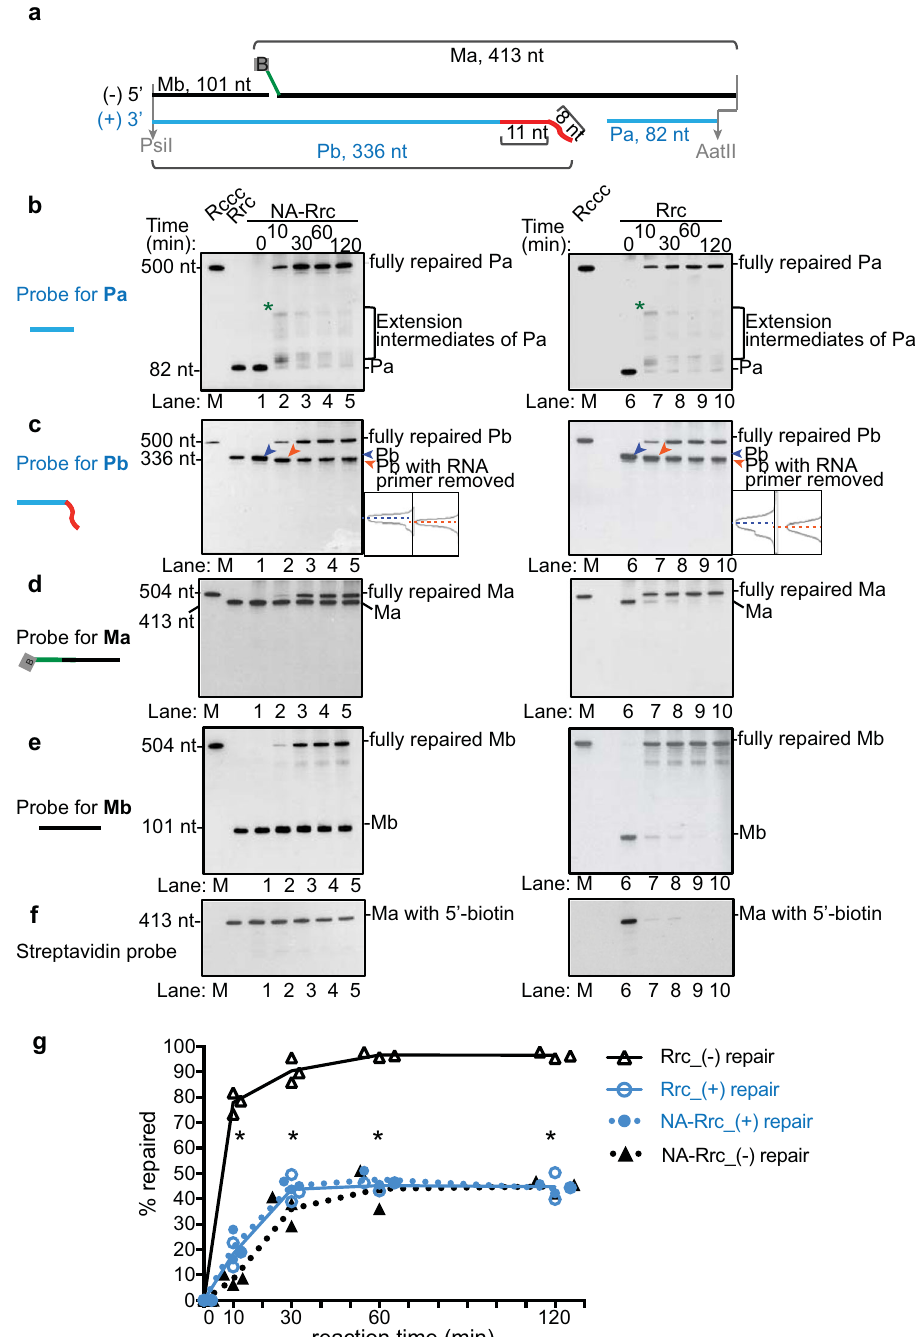
Fig. 3 Repair of HBV lesions in human nuclear extracts. a A simpli fi ed schematic depicting the four fragments in unrepaired RrcDNA digested by AatII/ PsiI. b NA-RrcDNA (lanes 1 – 5) or RrcDNA (lanes 6 – 11) was incubated with human nuclear extracts in a time course assay. Repair products at various time points were digested with Aat II/ Psi I and subsequently resolved by UREA-PAGE gel. Repair of the plus-strand Pa fragment was monitored by Southern blot as in Fig. 2d. “ * ” indicates extended Pa fragments that reach the 5 ′ terminus of Pa. c Repair of the plus-strand RNA primer-containing Pb fragment was monitored by Southern blot as described in Fig. 2e. Traces with dashed blue and orange lines denote unprocessed (blue arrow head) and processed product (orange arrow head) of Pb fragments. d – e Repair of the minus-strand Ma and Mb fragments were monitored by Southern blot as in Fig. 2f, g. f Removal of the biotin-containing fl ap of Ma was detected by streptavidin blot as in Fig. 2h. g The repair ef fi ciency of plus- and minus-strands is calculated from c and d and plotted as in Fig. 2i. ( − ) and ( + ) repair denote repair of minus and plus-strands, respectively. All experiments were repeated three times, and each individual measurement is plotted. The lines connect the average value of three measurements at each time point. Statistical analyses between the repair ef fi ciencies of the minus strand at each time point are performed by two-stage step-up t test method from Graphpad Prism. P values are 0.00001, 0.0003, 0.0003, and 0.000005 at indicated time points (*). Source data are provided as a Source Data fi